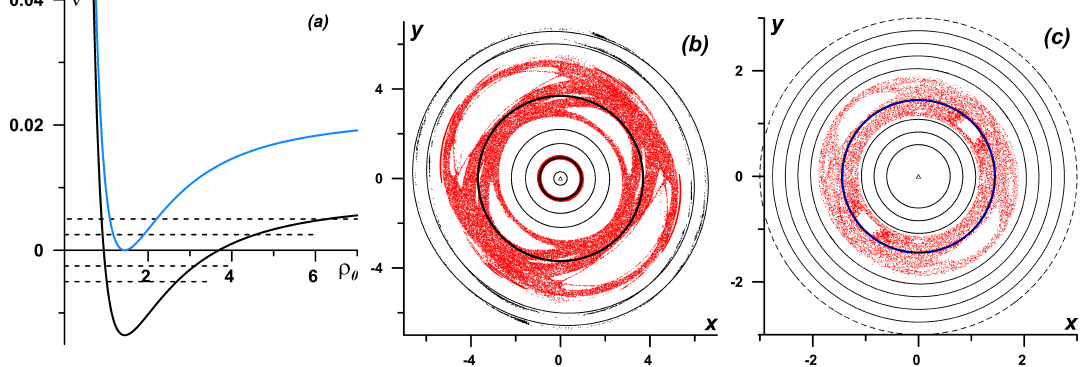
Figure 9. ( a ) Steady-state rotational frequency curves for the case of a deformation flow with zero mean strain (the black curve is Ω 0 = 0.10045 and the blue curve is Ω 0 = 0.27094); and their corresponding Poincaré maps with perturbation magnitudes: ( b ) ε = 0.005; and ( c ) ε = 0.003. Perturbation frequency, ν = 0.005, and its half (and also the corresponding negative values) are plotted as dashed